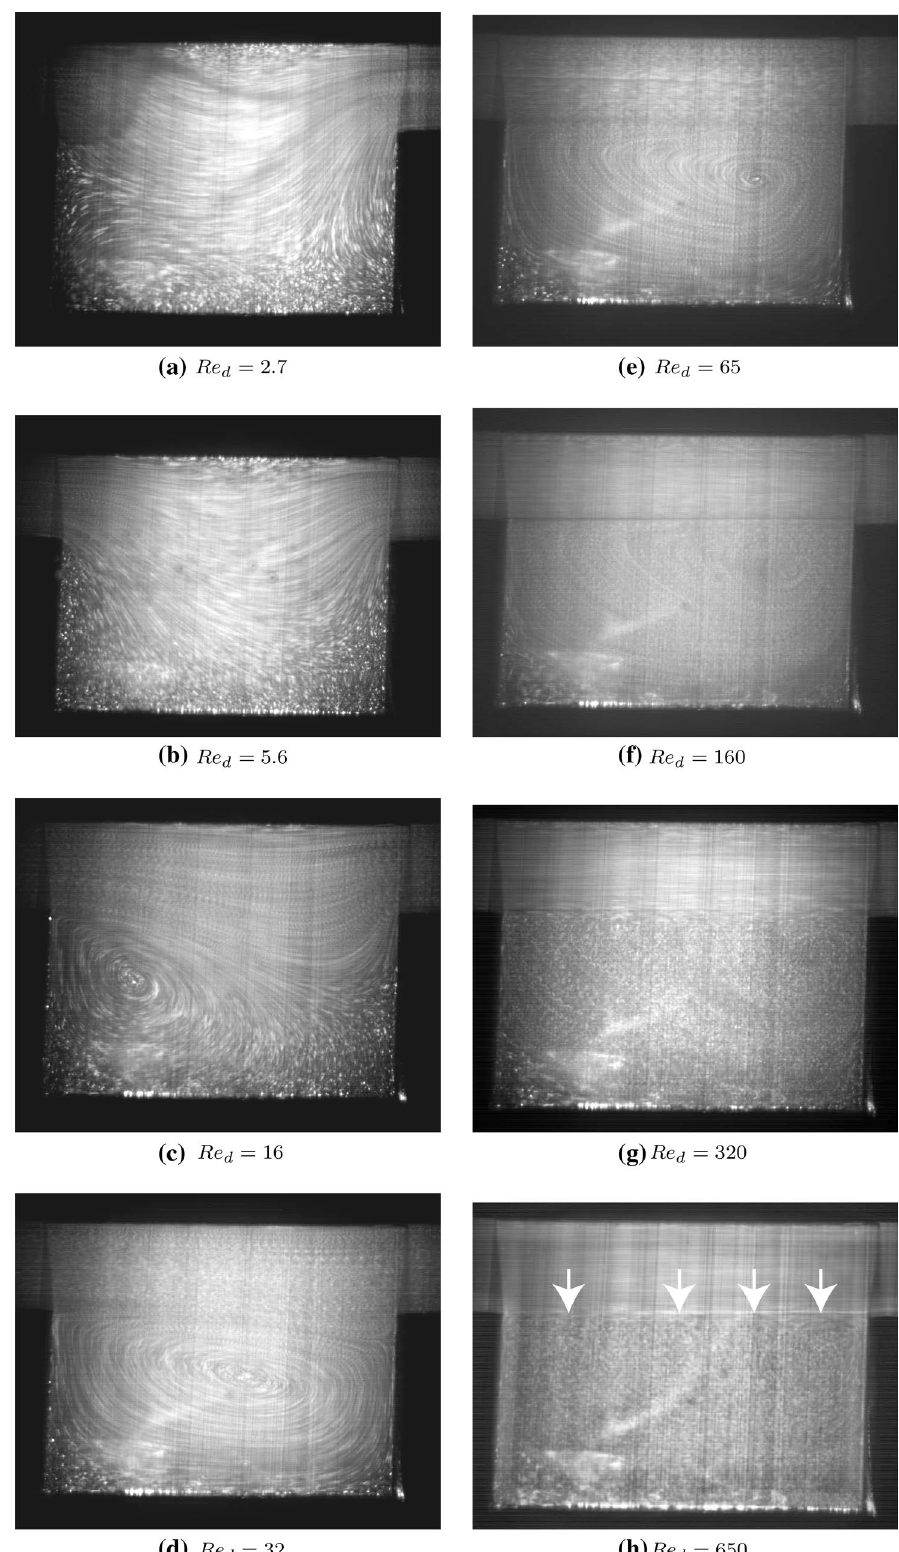
Fig. 3 Short time-averaged images for the cases compiled in Table 1. The arrows in (h) show blurred signatures of instabilities developing at the free edge of the